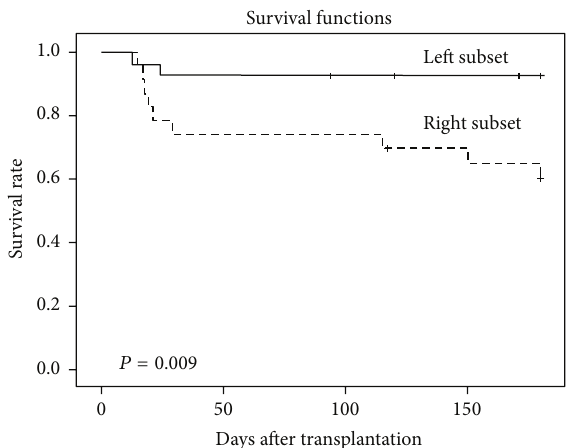
Figure 3: The association between serum adhesion molecule profile and survival. The serum profile of endothelium-derived soluble adhesion molecules identifies two major patient subsets that differ in survival. Based on the analysis presented in Figure 2 we identified two main patient clusters. We did a Kaplan-Mayer analysis to compare the survival between these two subsets, and a significant differencewasthendetectedbetweenthetwogroups.Thisdifference was caused by nonrelapse